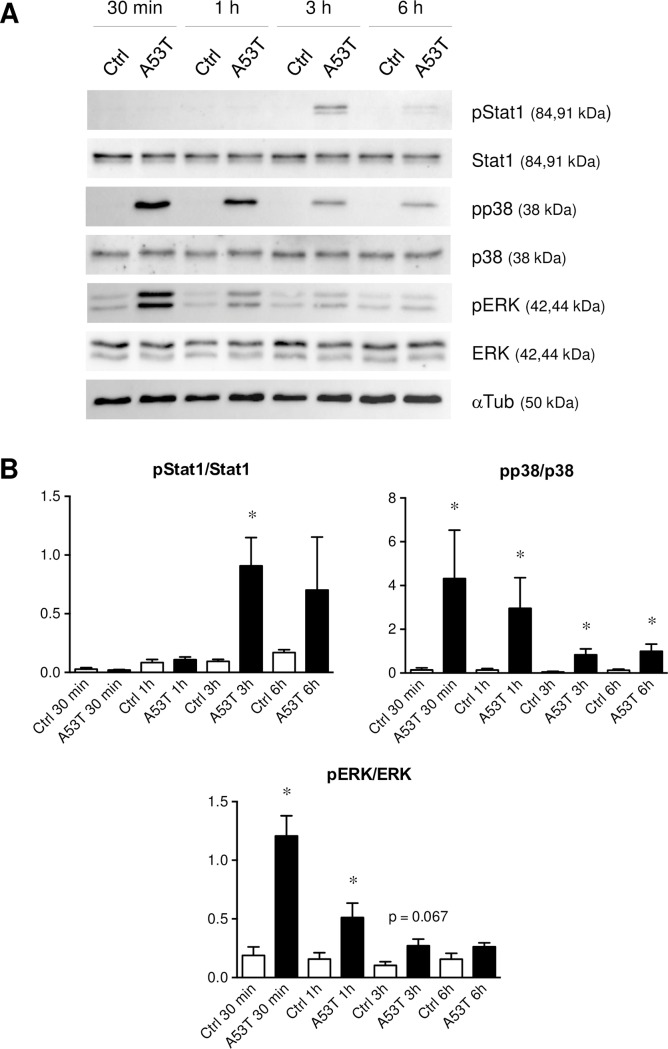
A53T protein induces STAT1 phosphorylation and MAPKs activation.After 30 min, 1 h, 3 h or 6 h of A53T protein exposure (5 μM), microglial cell lysates were subjected to western-blot analysis (Fig 5A) to determine the expression of phospho-Stat1 (pStat1), phospho-p38 (pp38) and phospho-ERK (pERK). α-Tubulin (αTub) was used as a loading control. These chemiluminescent detection assays were realized with 20 μg of total proteins. Ratios between phosphorylated versus non-phosphorylated proteins, called pStat1/Stat1, pp38/p38 and pERK/ERK, were described in Fig 5B. Results are given as mean ± SEM of at least three independent experiments. * p < 0.05, significantly different from control condition.